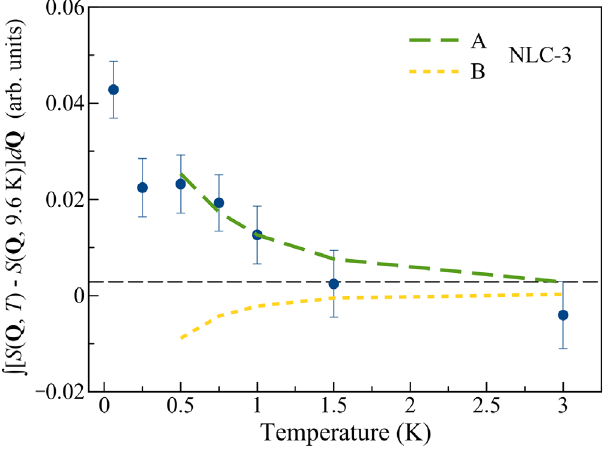
FIG. 10. The results of the NLC S ð Q ; T Þ calculation to third order using the A and B exchange parameters, overlaid on top of the measured neutron scattering intensity from our Ce 2 Zr 2 O 7 sample. Here we compare the temperature dependence of the measured and calculated integrated intensities for the T ¼ 9 . 6 K temperature subtraction, with integration over the energy-transfer range E ¼ ½ − 0 . 2 ; 0 . 4 (cid:2) meV and integration in wave vector over the range j Q j ¼ ½ 0 . 46 ; 0 . 93 (cid:2) Å − 1 . The temperature dependence of the NLC-calculated integrated S ð Q ; T Þ agrees well with that of the measured data when using parameter set A, but clearly does not for set